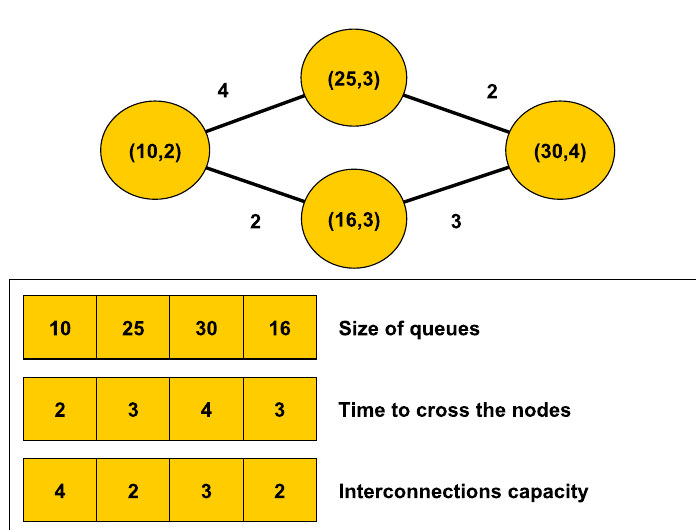
Figure 2. Example of coding a simulation graph as an individual of the genetic algorithm.